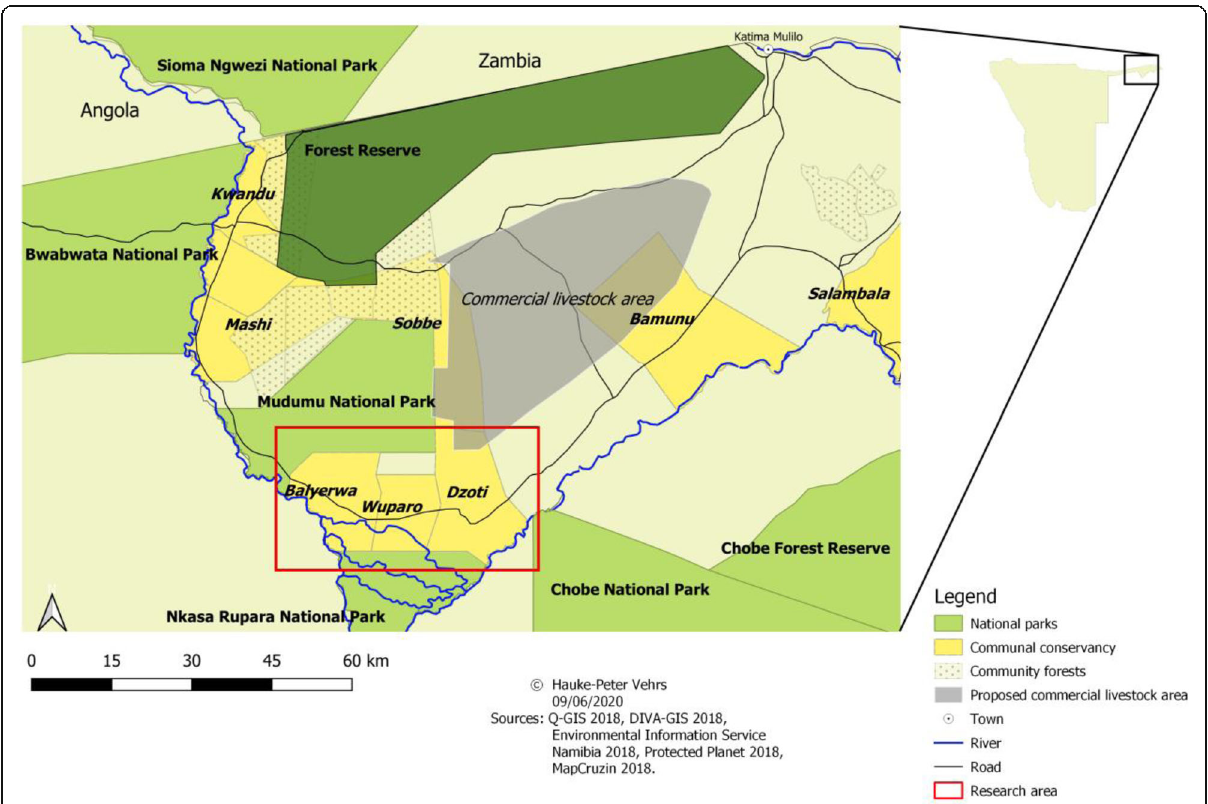
Fig. 1 Research area Mudumu South; the map shows the two national parks, the three conservancies, and the planned commercial ranching zone east of Mudumu National Park Source: QGIS Development Team 2018; DIVA-GIS 2018; Environmental Information Service Namibia 2018; Protected Planet 2018; MapCruzin